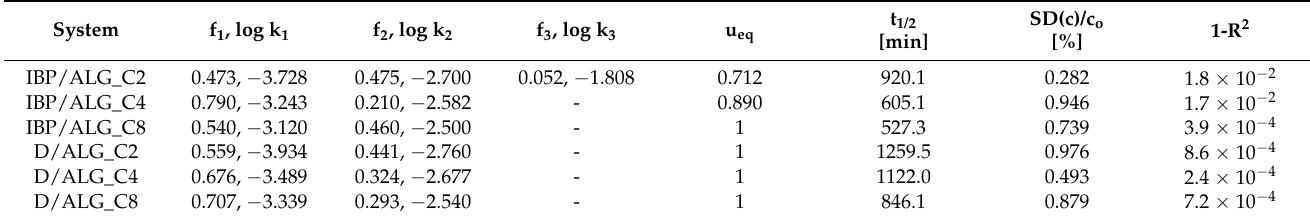
Table 5. Optimized parameters of m-exp equation.